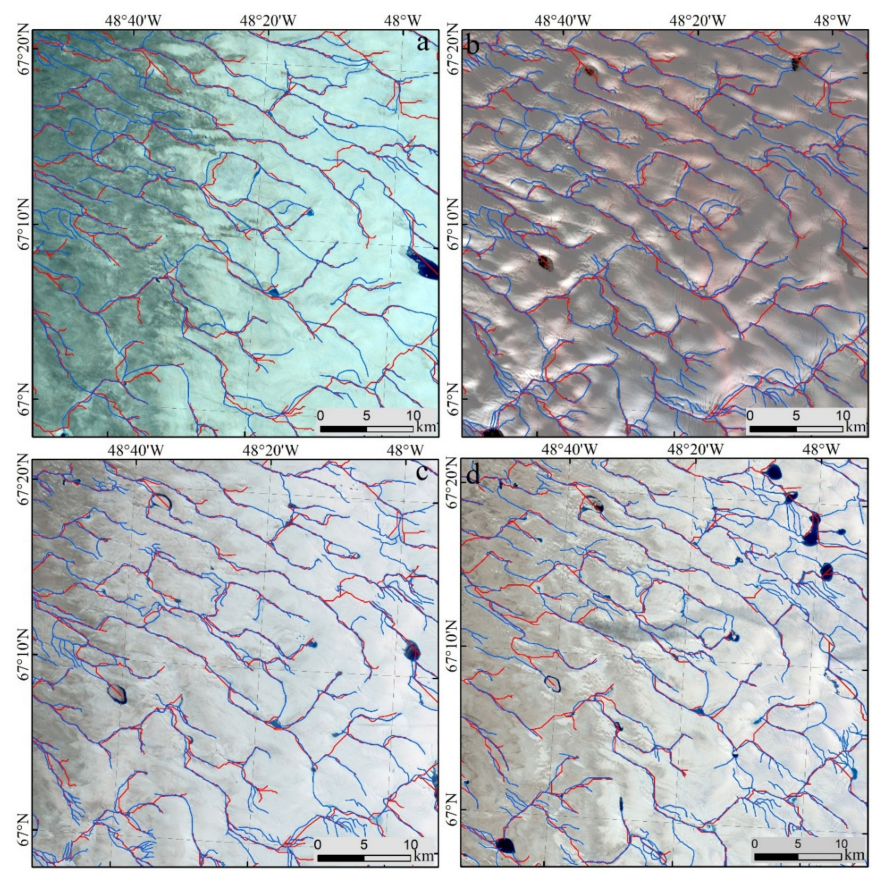
Figure 7. Comparison of remote sensing images and river network results in di ff erent years. The background images in ( a – d ) are from Landsat-8, and the acquisition dates are July 16, 2012; August 19, 2013; August 6, 2014; and July 10, 2016, respectively. The blue line is the river network digitized based on the Landsat images. The red lines in ( a – c ) are the river networks extracted from TanDEM-X. The red line in ( d ) is from ArcticDEM.